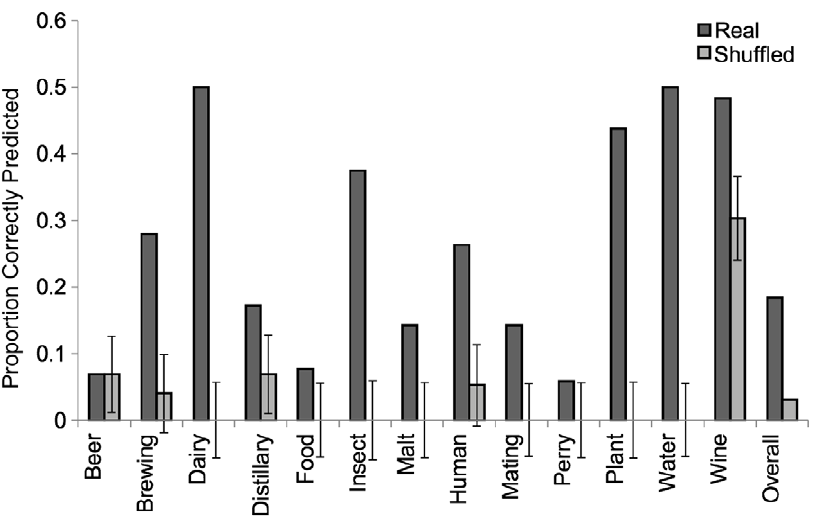
Figure 6. The substrate a strain was isolated from can be predicted based on the set of carbon sources a strain can utilize. Dark gray bars represent the proportion of time that a substrate was correctly predicted. Lighter gray bars represent the background prediction rate and associated confidence intervals based on shuffled data. There was no predictive power for 6 substrates (not shown).